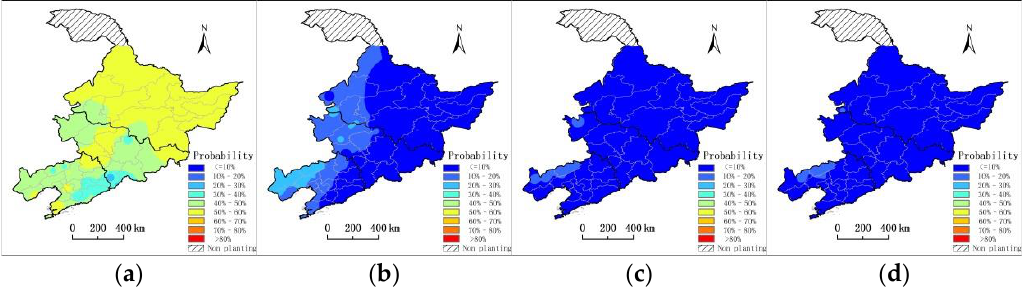
Figure 10. Spatial distributions of the joint probabilities for agricultural drought events with differ- ent drought grades in Northeast China from 1981 to 2020. ( a ) Light drought; ( b ) moderate drought; ( c ) Severe drought; ( d ) Extreme drought. ( c ) Severe drought; ( d ) Extreme